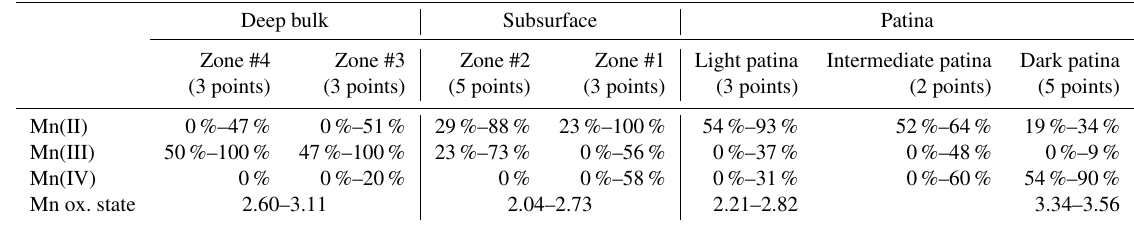
Table 3. Relative proportions of Mn(II), Mn(III), and Mn(IV) determined using the Combo method in L2 regions of interest. Deep bulk